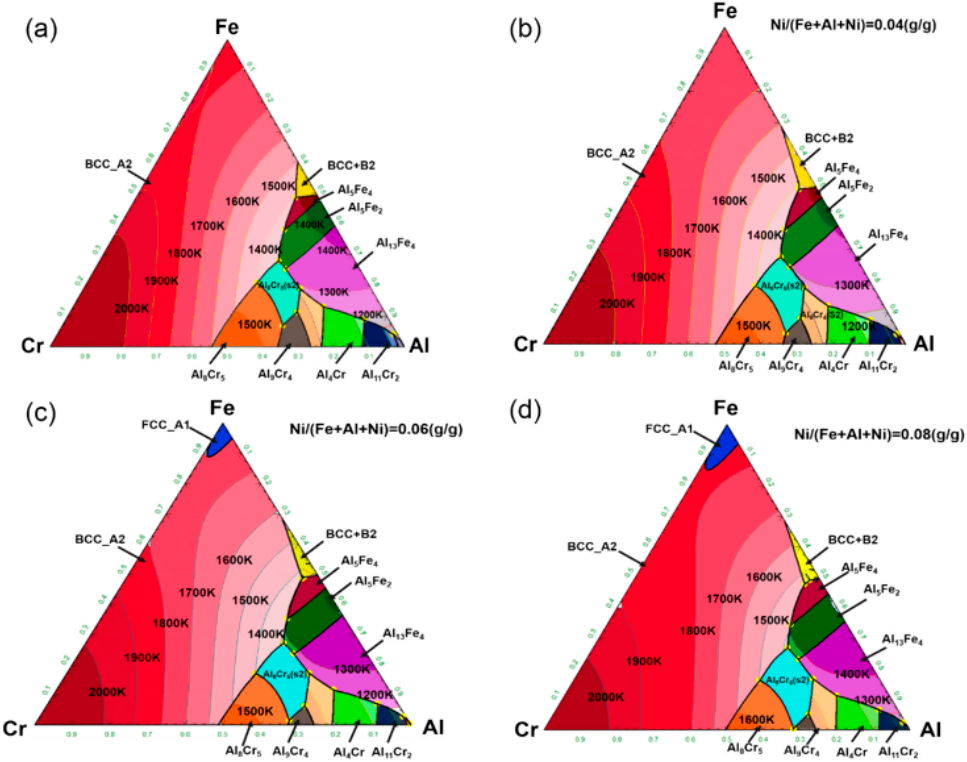
Figure 6. E ff ect of Ni addition on the Fe–Al–Cr phase diagram (1000–2000 K). ( a ) Ni / (Fe + Al + Cr) = Figure 6. Effect of Ni addition on the Fe–Al–Cr phase diagram (1000–2000 K). ( a ) Ni/(Fe + Al + Cr) = 0 0 wt.%; ( b ) Ni / (Fe + Al + Cr) = 4 wt.%; ( c ) Ni / (Fe + Al + Cr) = 6 wt.%; and ( d ) Ni / (Fe + Al + Cr) = wt.%; ( b ) Ni/(Fe + Al + Cr) = 4 wt.%; ( c ) Ni/(Fe + Al + Cr) = 6 wt.%; and ( d ) Ni/(Fe + Al + Cr) = 8 wt.%. 8